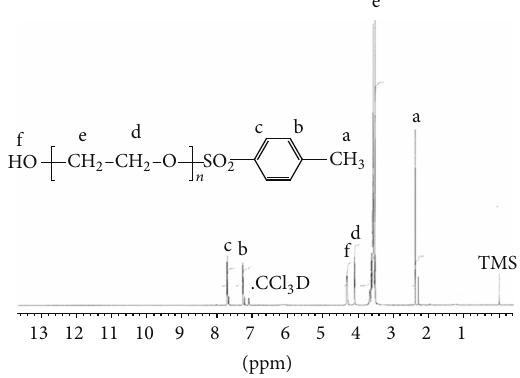
Figure 2: 1 HNMR spectrum of PEG-Tos in deuterated